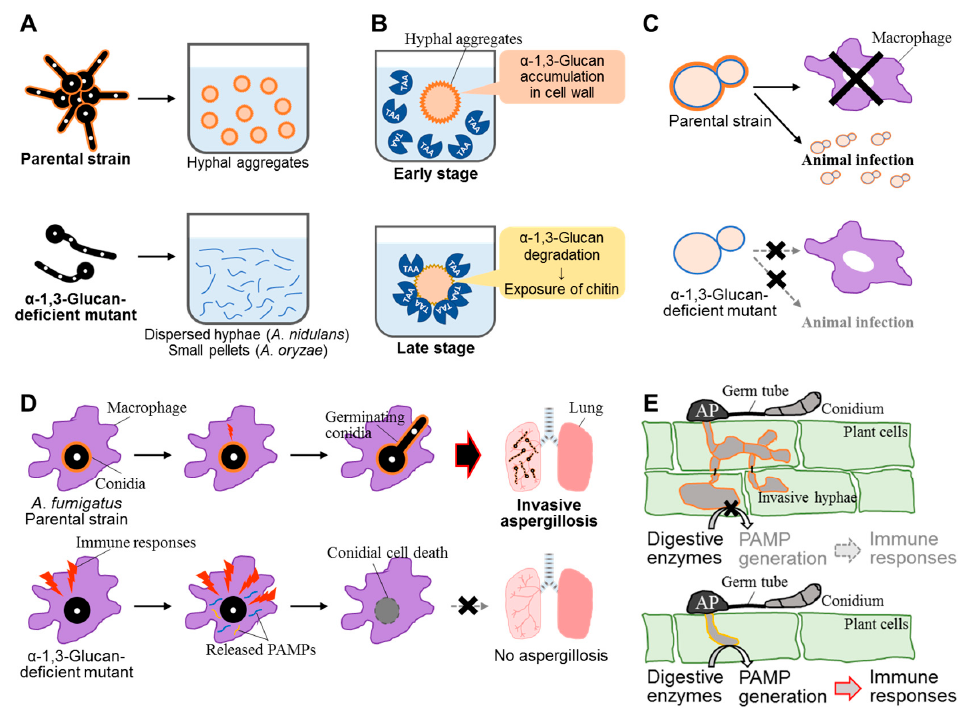
Figure 3. Various functions of α -1,3-glucan in fungi. ( A ) Swollen conidia of Aspergillus